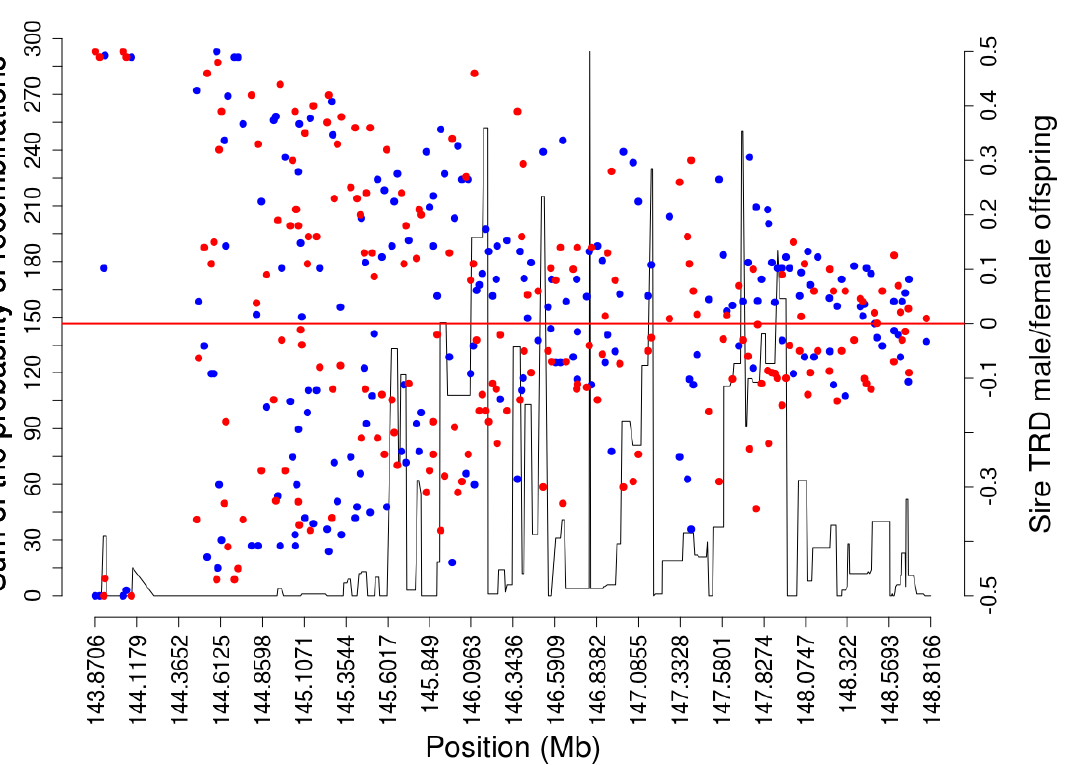
Figure 4. Overlapping between opposite sire-TRD (right y-axis) and sum of the probability of recombination (left y-axis) in the main pseudoautosomal part of the bovine X-chromosome (143,865,210–148,816,634 bp). The x-axis shows the genomic coordinated in Mega bases (Mb). The red and blue dots correspond to the sire-TRD magnitude in the male and female offspring, respectively.